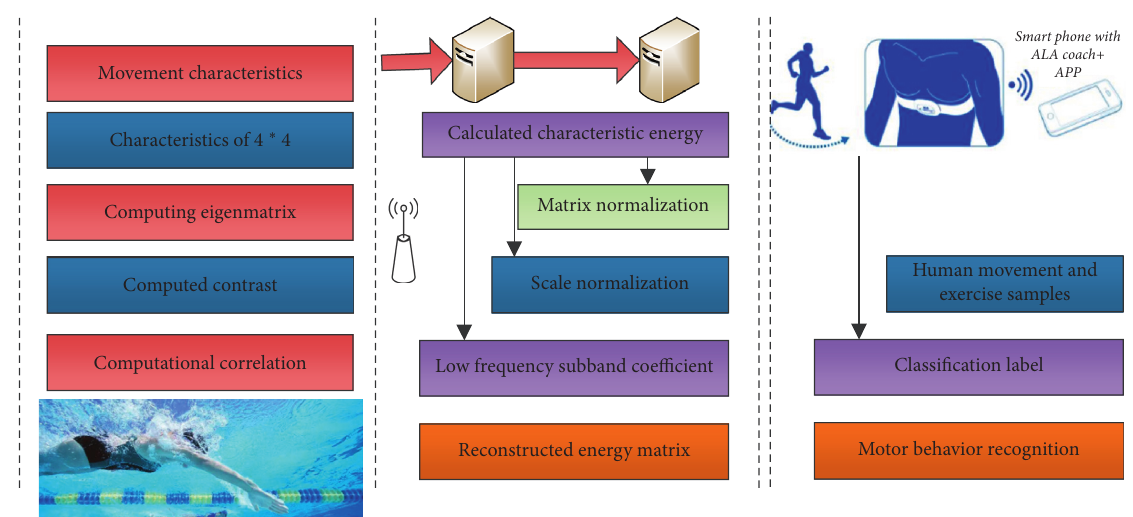
Figure 3: Motion and exercise recognition feature extraction method.